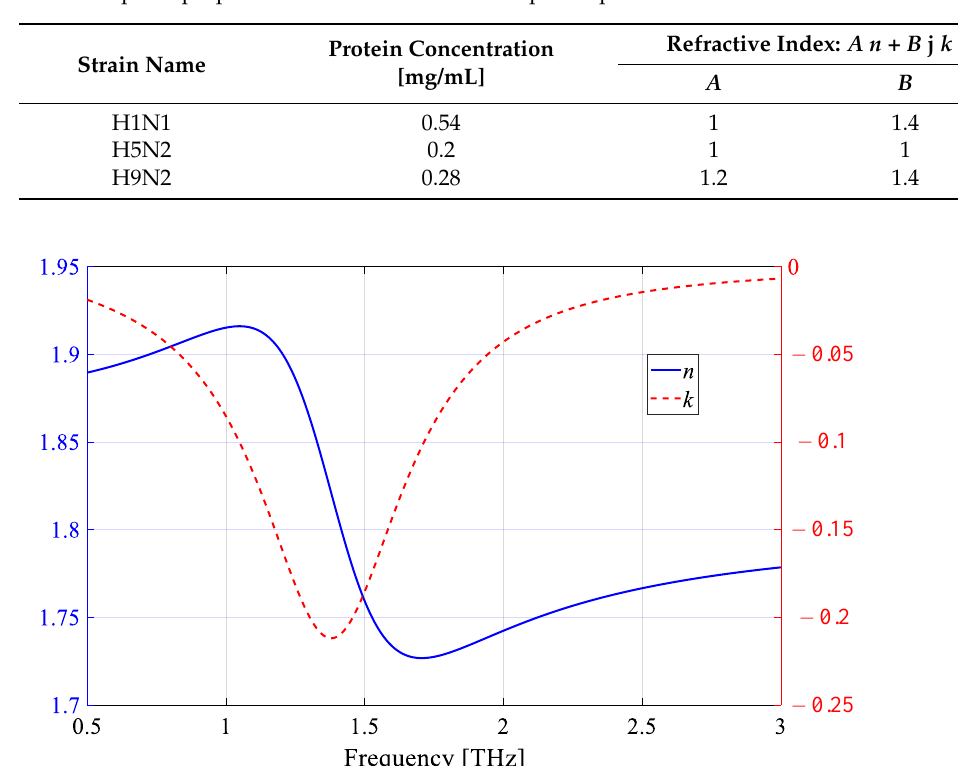
Figure 3. Real ( n ) and imaginary ( k ) part of the refractive index for H9N2.